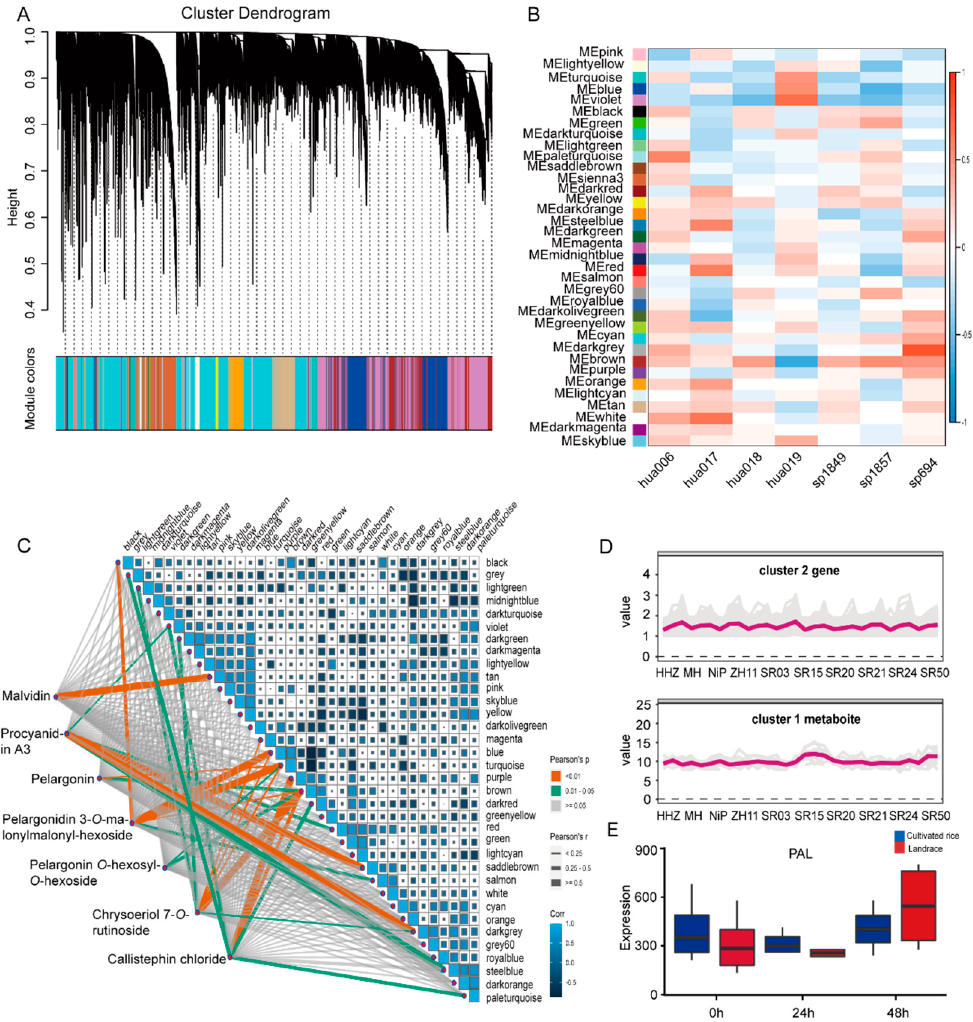
Figure 4. Correlation network analysis based on metabolites and genes in the seeds of landraces and cultivated rice during germination. ( A ) Construction of a co-expression gene module. The same color represents the same module. If the module feature genes between two different modules are similar, they will be merged automatically. ( B ) Heatmap between metabolites and 35 gene modules. Y -axis represents each module, and the X -axis represents each trait. Red shows upregulated tran- scripts, and blue shows downregulated transcripts. ( C ) Co-expression network of genes in modules. ( D ) Dynamic of metabolite accumulation and gene expression in co-expression clusters. Metabolite and gene clusters are represented by red. The numbers of the X -axis indicate the germination stage. ( E ) The expression level of PAL in the seeds of landraces and cultivated rice during